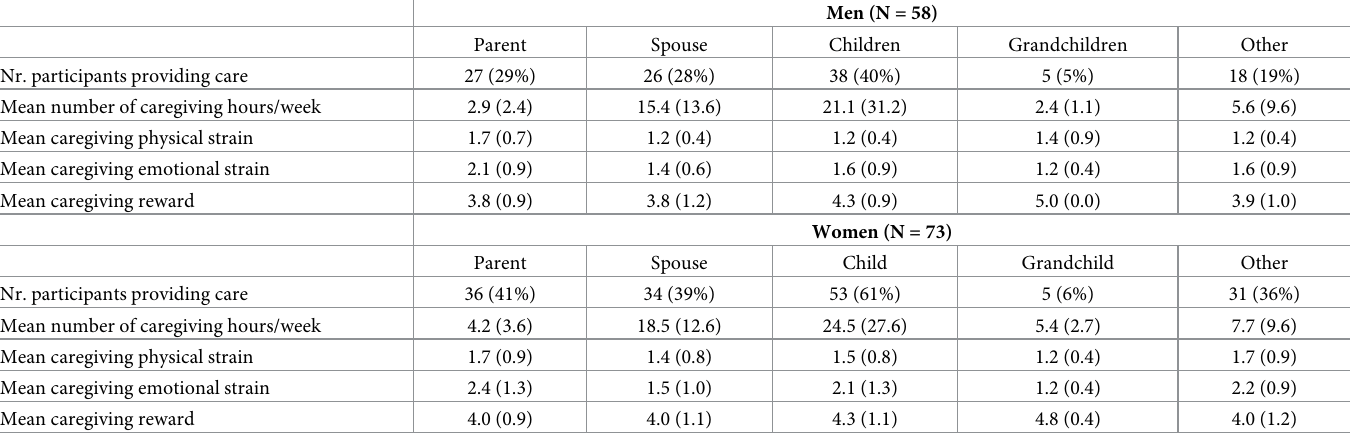
Table 2. Distribution of family responsibility characteristics by gender and care